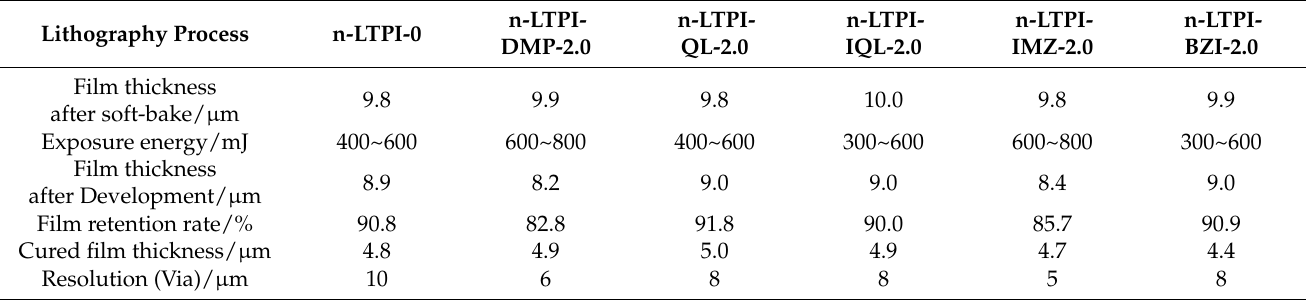
Figure 3. Photo-patterning of n-LTPI: ( a ) Spin-coated and soft-baked coating on 12-inch wafers. ( b ) The photo-patterning on wafer. ( c ) With 5 μ m diameter. Table 1. Lithographic performance of the low-temperature curable photosensitive polyimides.